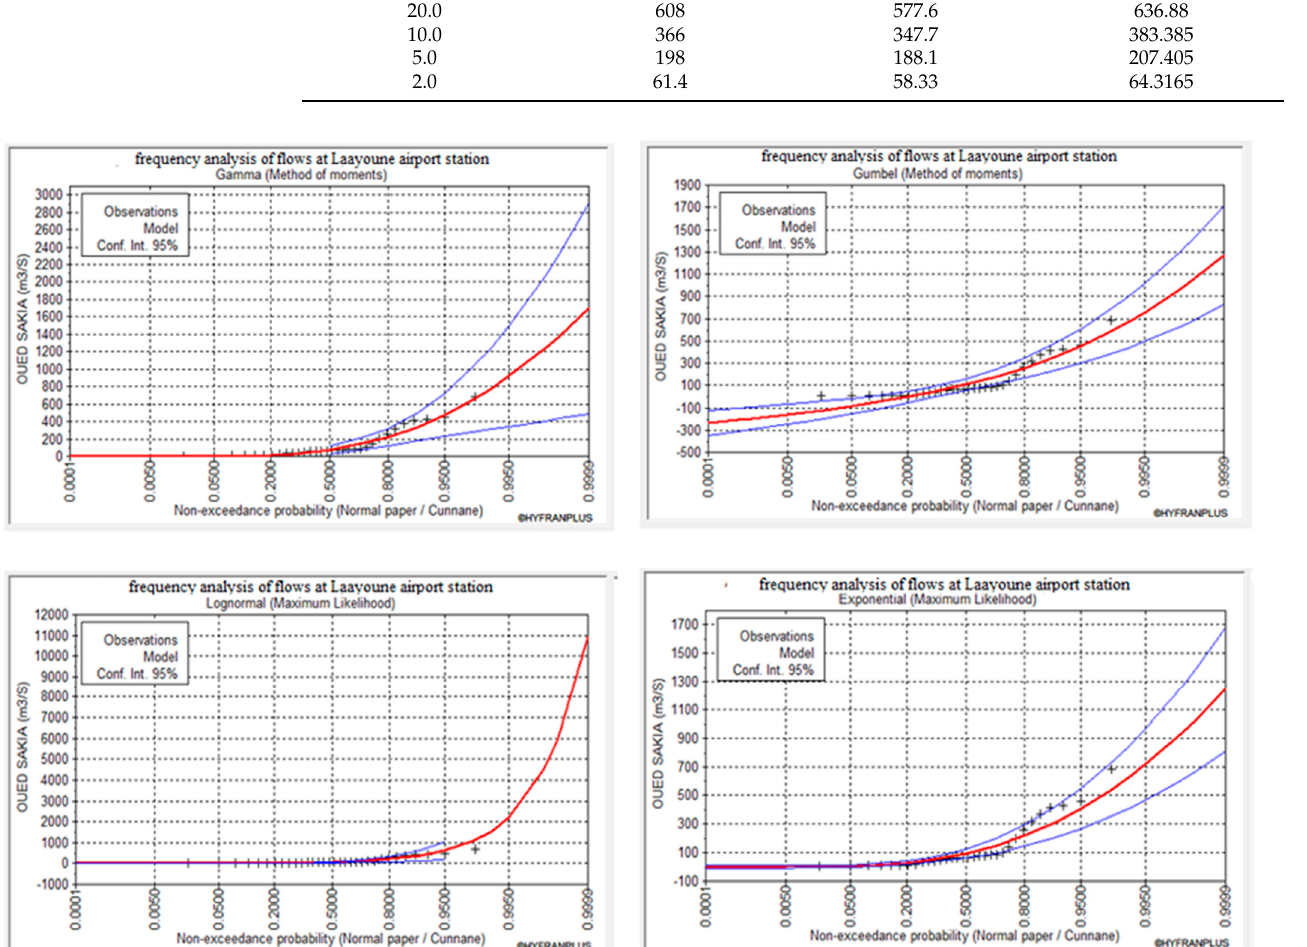
Figure 11. Cross-sections and flow direction. The axis of the stream in blue, the sections in green and the banks in red. Figure 12 shows the flood extent of the studied event, and Figure 13 depicts the flood propagation outcomes for various return periods. Arc GIS uses the results of the hydraulic simulation to produce maps of the floodplain and its limits for various return periods (Q20, Q50, Q100). The results showed that, during flash floods with known flows, the